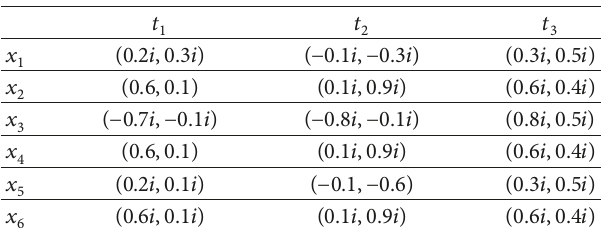
Table 4: TCIFS A (𝑇) .